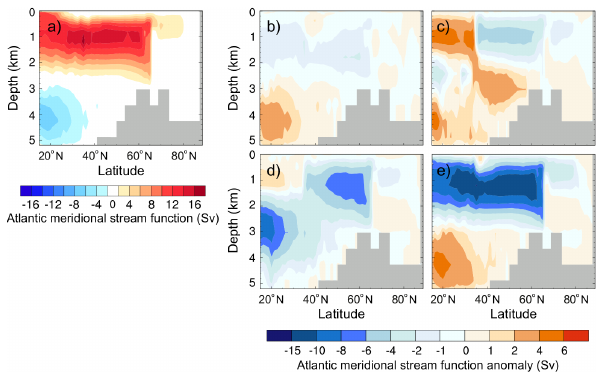
Fig. 5. Atlantic Meridional Overturning Circulation (AMOC) stream function (inSv) for (a) Messinian control ; and AMOC stream function anomalies, given with respect to Messinian control , for (b) no-exchange , (c) halite-quarter , (d) gypsum-half and (e) fresh-normal . Positive (negative) stream function indicates strength in the clockwise (counterclockwise) direction. Note that because of the open Central American Seaway in the Miocene, the Atlantic basin is only enclosed north of 15 ◦ N; hence the stream function is plotted from 15 ◦ N to 90 ◦ N. Bathymetry is masked in grey.